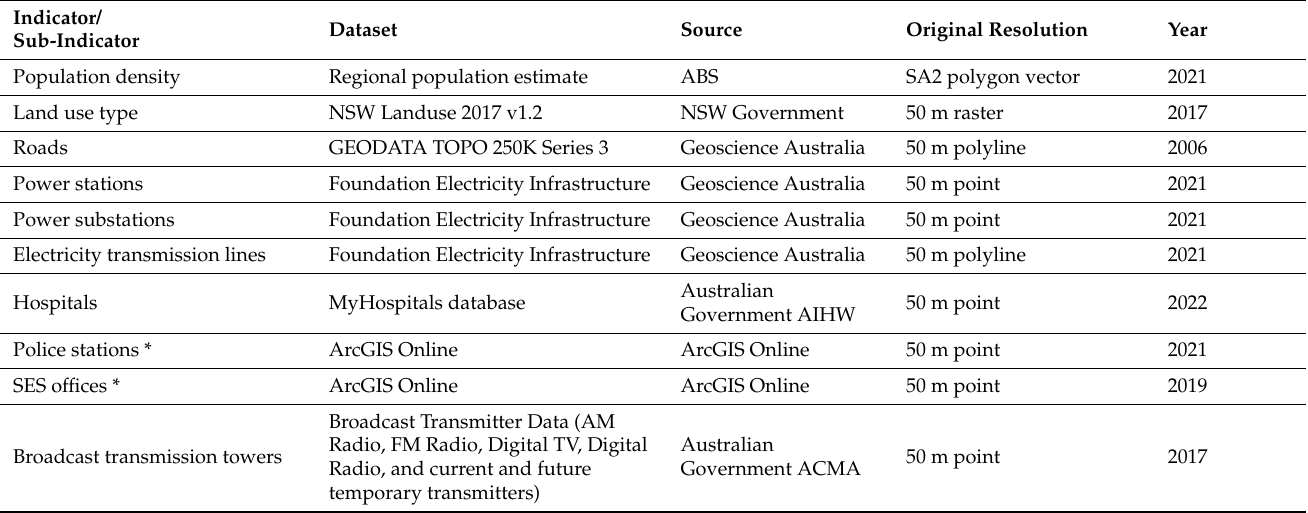
Table A2. Datasets and other relevant metadata for each of the three indicators in this study. Note that, following the population density and land use type indicators, data relates to sub-indicators within the critical infrastructure density indicator. All indicators were covered by a CC BY 4.0 licence. The two sub-indicators which were covered by a CC BY-NC 4.0 licence specifically are marked with an *.